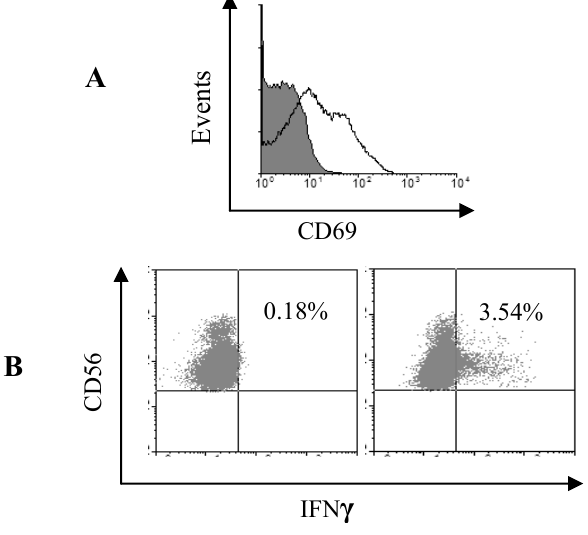
Figure 2. NK activation after a single freeze/thaw cycle. Isolated NK cells were cryopreserved and re-thawed for use in later experiments. A) NK cells cultured for 24 hours in the absence (filled histogram) or presence of IL-2 (clear histogram) were labelled with anti-CD56, CD3 and CD69 antibodies. Histograms show CD69 expression on CD56 + CD3 - cells. B) NK cultured alone for 24 hours (left dot-plot) or with IL-2, 50 units/mL, (Right dot-plot) and stained for intracellular IFN γ . Dotplots show 50,000 acquired events gated on live CD56 + CD3 -